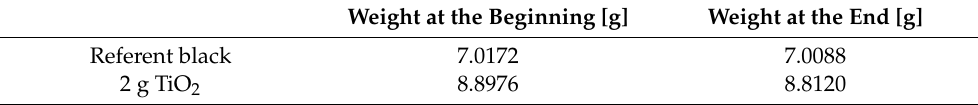
Table 2. Weighing results of samples of black rubber before and after the leaching